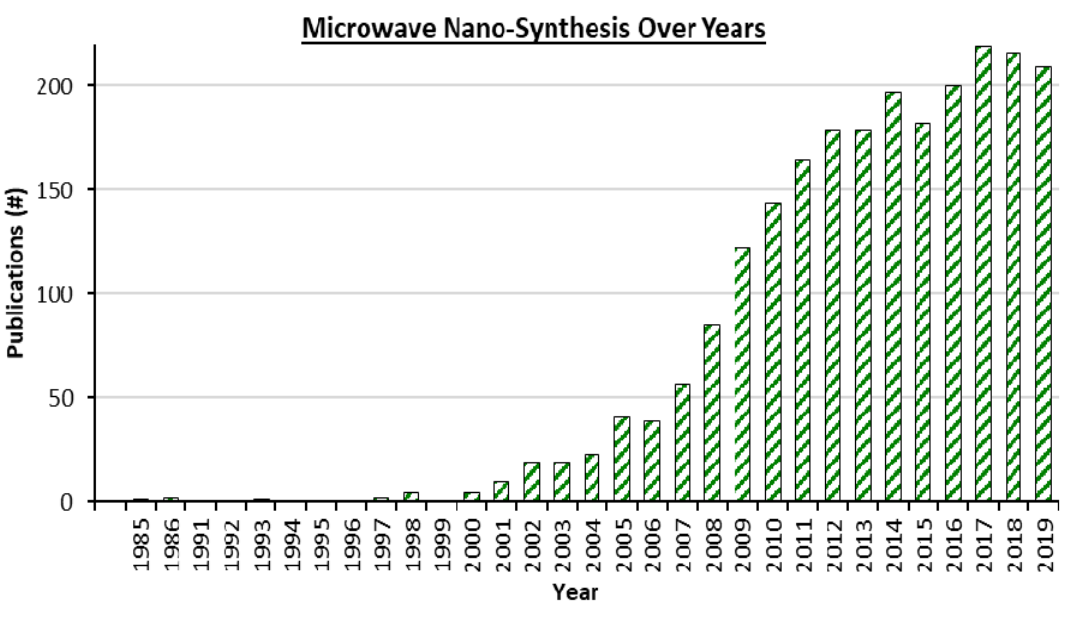
Figure 1. A bar graph showing µw-related papers over the years, data were obtained from Scopus using the keyword: “microwave synthesis nano” on 07/17/2020; statistics for 2020 was not included.